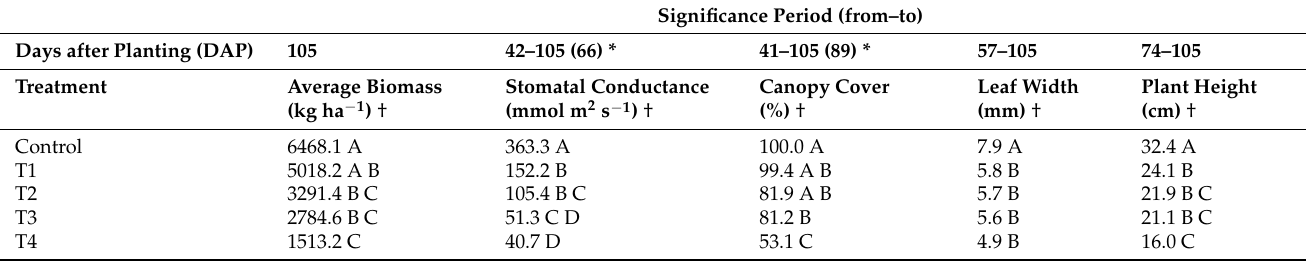
Figure 5. Stomatal conductance ( gs ) of ryegrass ( Lolium perenne ) during the growing season under different irrigation treatments. Control: non-stressed treatment, T1: moderate–low water stress treatment, T2: moderate–high water stress treatment, T3: medium intensity severe water stress treatment, T4: high intensity severe water stress treatment. The first cutting was made on day 105. The solid line connects the gs means, and the shaded area shows the standard deviation from the mean values. Table 3. Effect of water stress treatments on the response variables in the first crop cycle ryegrass. ( Lolium perenne